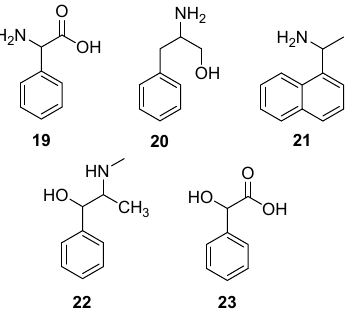
Figure 2. Schematics of model compounds used for enantioenrichment studies.